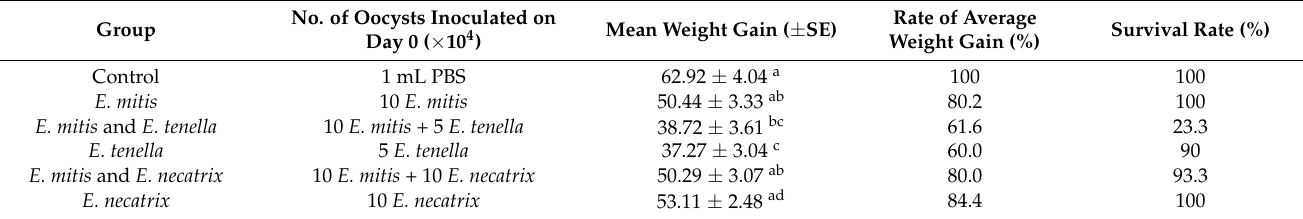
Table 1. The effect of E. mitis and E. tenella , E. necatrix in pure and mixed infections in chicks. No. of Oocysts Inoculated on Group Day 0 ( × 10 4